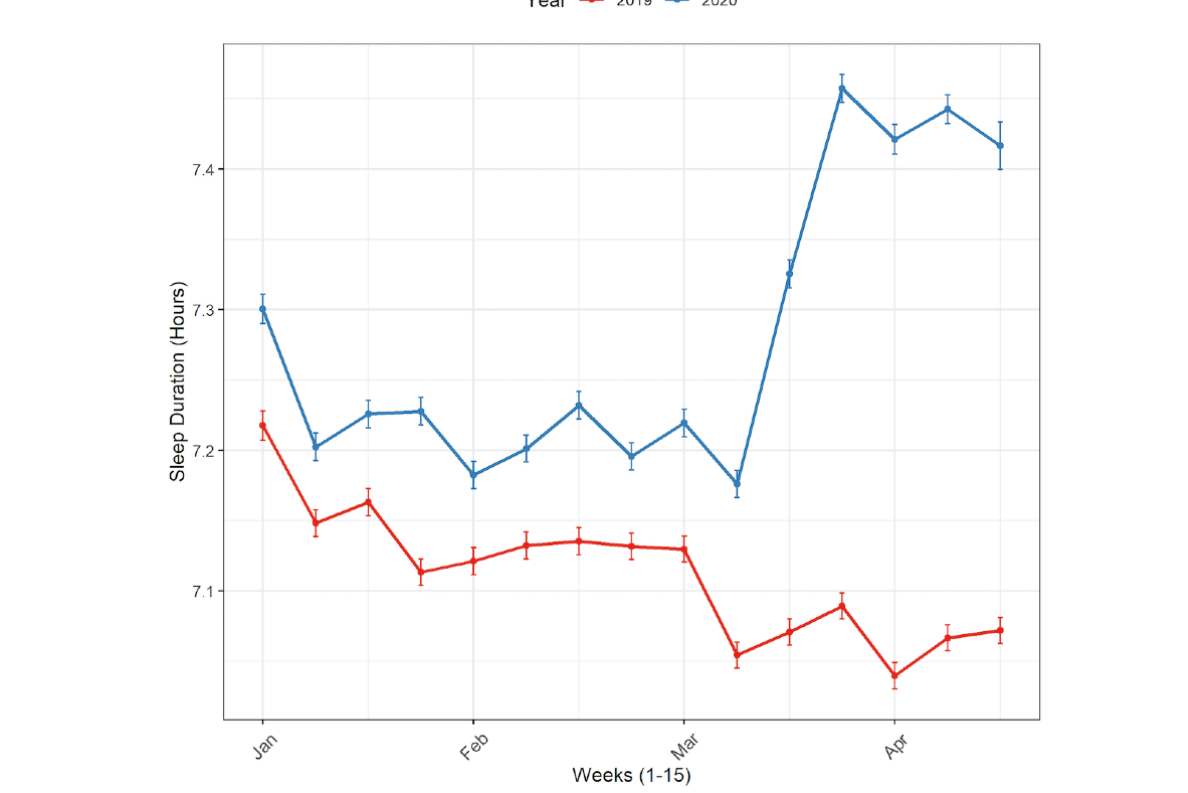
Figure 2. Estimated sleep duration by months (January to April) in 2019 and in 2020 for the total sample by city.